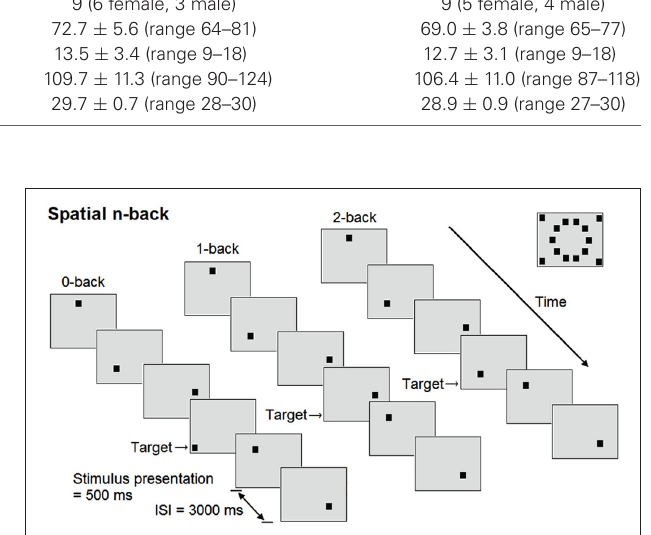
FIGURE 1 | Schematic overview of the spatial n-back task . At the right upper corner of the figure, all possible positions of the square are shown. ISI = interstimulus